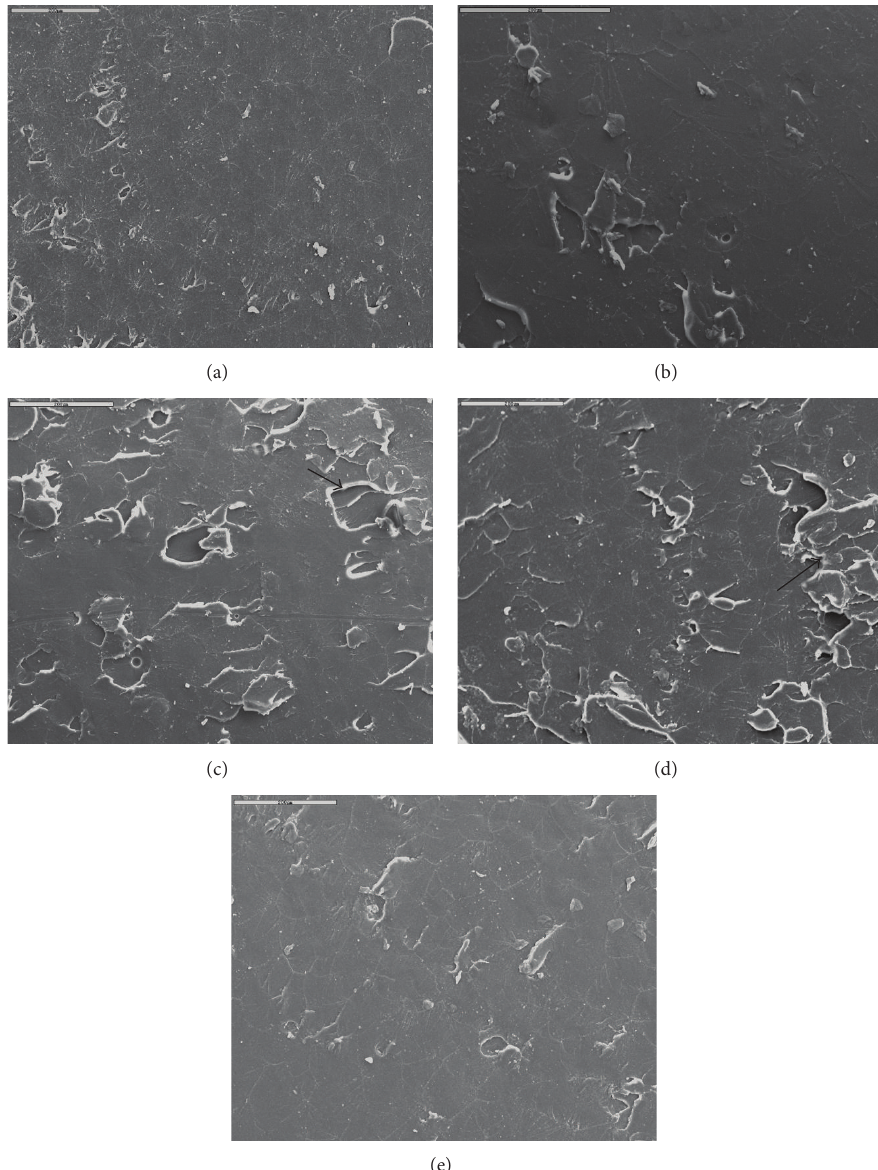
Figure 7: SEM images of brittle fractures of PMMA denture base material modified with (a) 2.5 wt% of DMI, (b) 2.5 wt% of DBI, (c) 10 wt% of DMI, (d) 10wt% of DBI, and (e) commercial PMMA denture base material (original magnification 200